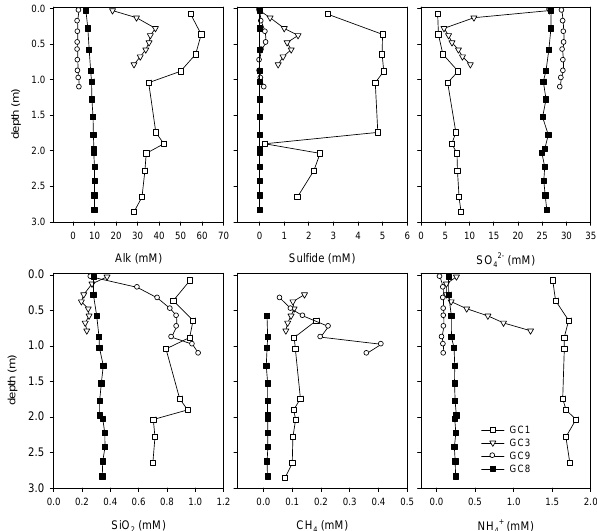
0.0 0.1 0.2 0.3 0.4 0.5 CH 4 (mM) Fig. 5. Porewater chemistry profiles obtained from sediments re- trieved by the gravity corer (GC). The data from the reference core (GC 8), taken approximately 1km southwest of the vents, are indi- cated with black symbols. GC 9 was obtained 50m south of Abyss Vent; GC 1 and 3 were taken near the Swallow Fig. 5